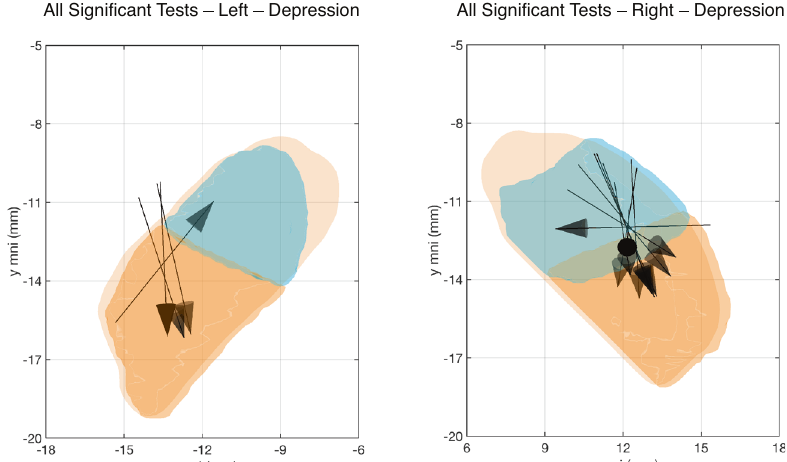
Fig. 4 Variation along the anterior – posterior ( y ) axis primarily explains variation in postoperative performance in patients with a history of depression. Each vector identi fi ed by LDA and correlation analysis as representing a statistically signi fi cant linear relationship between contact location and postoperative performance on the respective cognitive test is superimposed on to one STN for each hemisphere for patients with a history of depression to illustrate the importance of the anterior-posterior vector component in this subgroup. For clarity, the fi gures have been simpli fi ed to 2 dimensions ( x and y ) only. The tripartite coloring of the STN re fl ects sensorimotor (orange), associative (turquoise), and limbic (tan) subregions according to the distal minimal